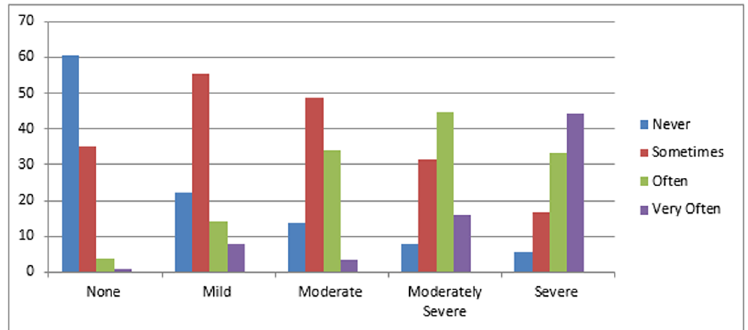
Fig 2. Functional impairment among the PHQ-9 score cut off depression subtypes on adult cancer